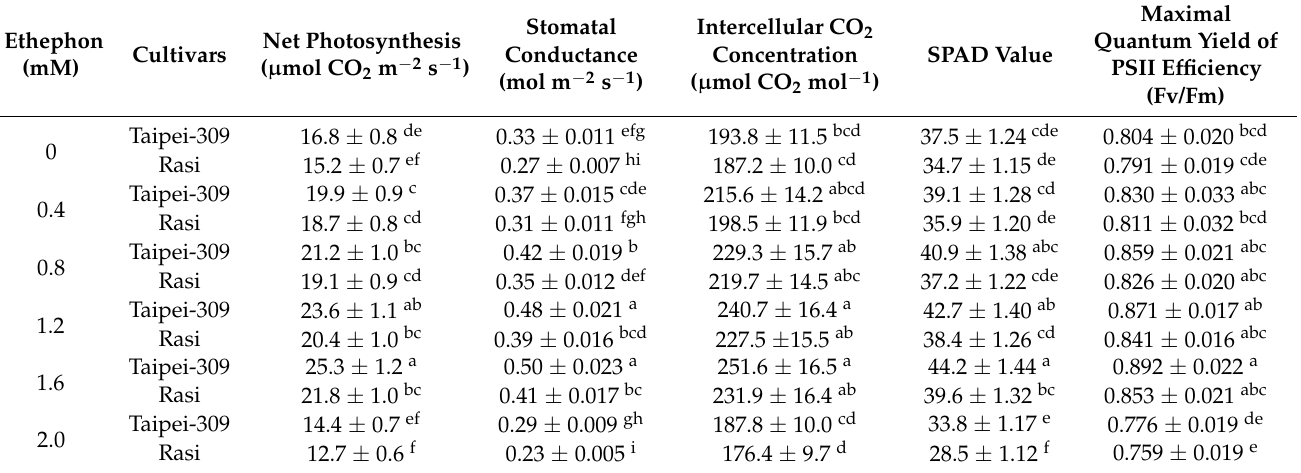
photosynthesis, stomatal conductance, intercellular CO 2 concentration, SPAD value, and maximal quantum yield of PSII efficiency (Fv/Fm) in Taipei-309 and Rasi cultivars of rice ( Oryza sativa L.) at 30 DAS. Data are presented as treatment means ± SE ( n = 4). Data followed by the same letter are not significantly different by the LSD test at p < 0.05. DAS, days after